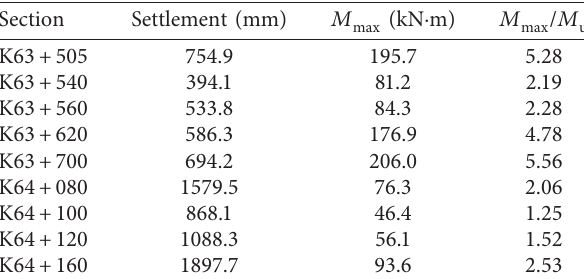
Table 5: Statistical table of settlements and bending moments.